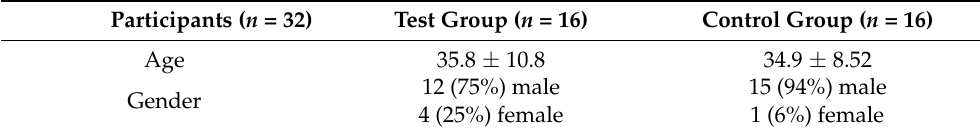
Table 1. Demographic